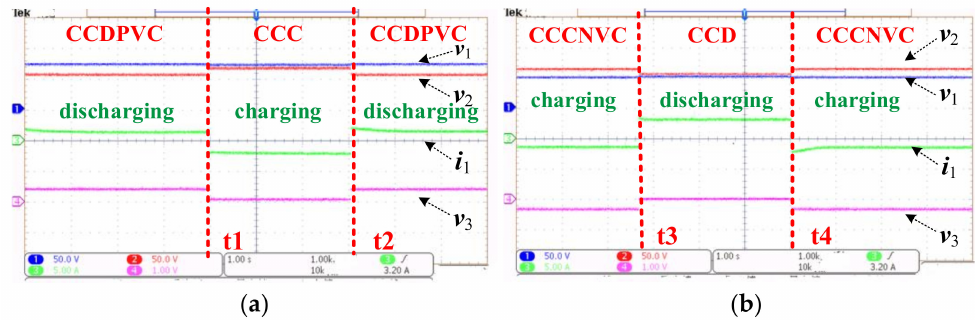
Figure 15. Waveforms during the transition process: ( a ) the battery voltage was lower; and ( b ) the battery voltage was